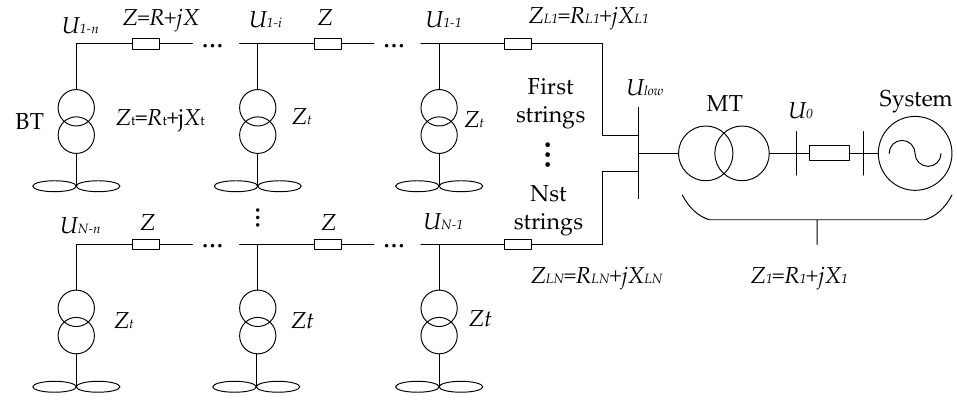
Figure 4. Topology of a collector line in WPP.